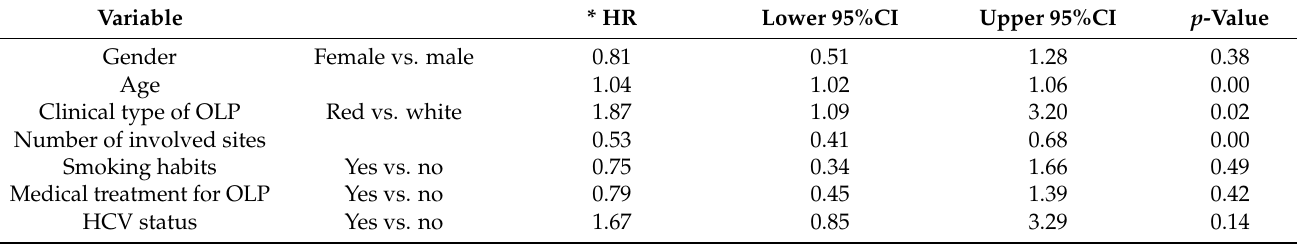
Table 3. The Cox proportional-hazards model was performed for investigating the association between time-to-onset of a tumor and factors of interest (gender, age at lichen diagnosis, type of lichen, number of sites involved, smoking habits, hepatitis C virus, and corticosteroid